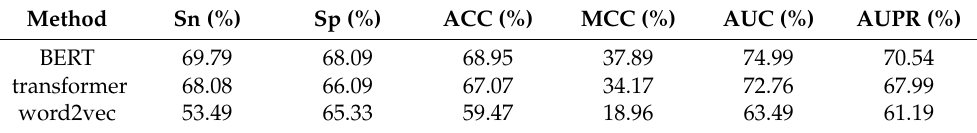
Table 1. Performance of three encoding methods on the independent set of Homo sapiens .